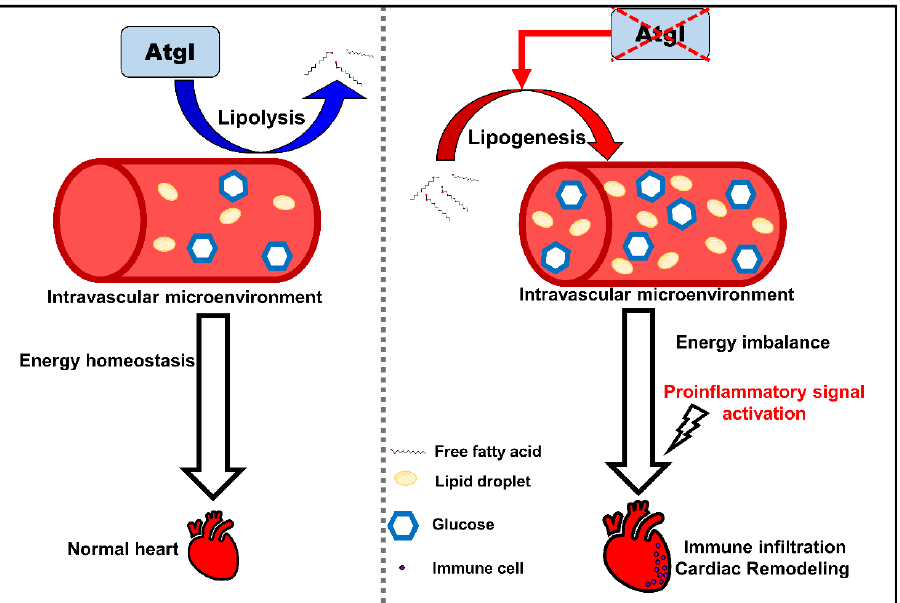
Figure 7. The schematic diagram summarizes the findings in this study. Defective Atgl activated lipogenic pathway leads to an energy imbalance microenvironment in the circulation system. Excess metabolites enhance cardiac remodeling by activating proinflammatory signals and immune cell recruitment.